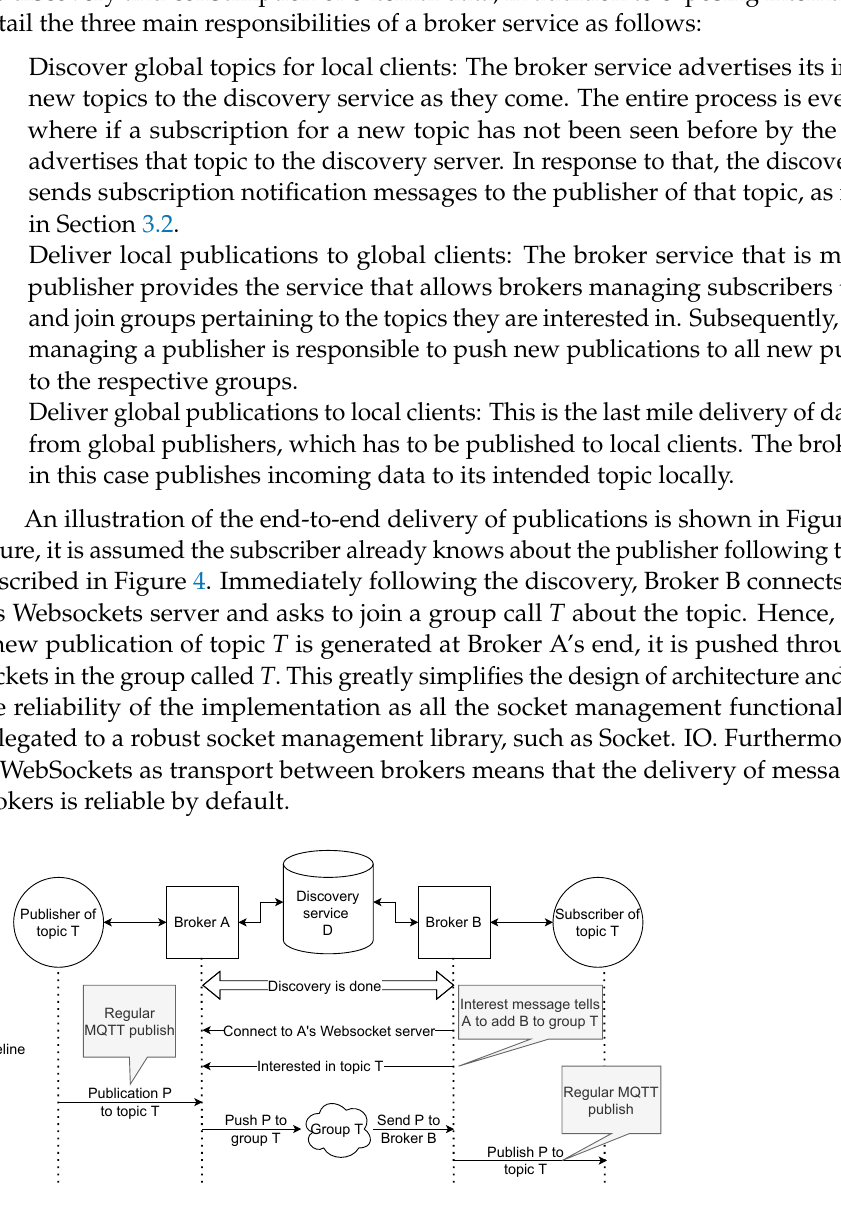
Figure 5. Illustration of the end to end delivery